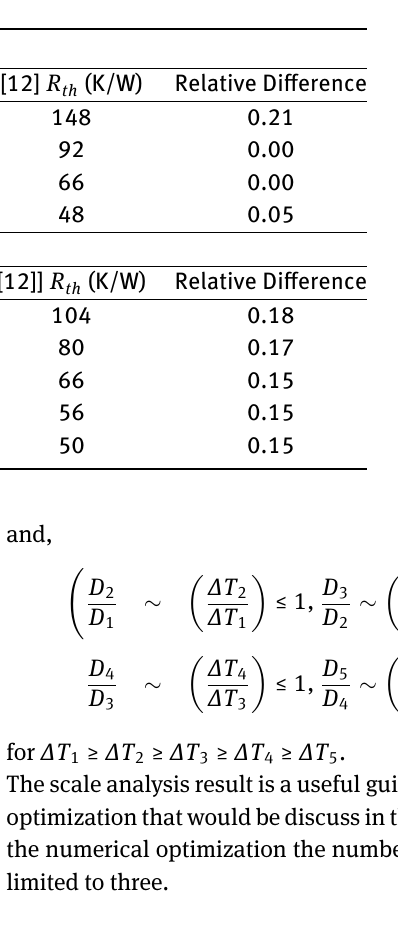
Table 2: Validation of code for thermal resistance versus (a) pin diameter (b) pin